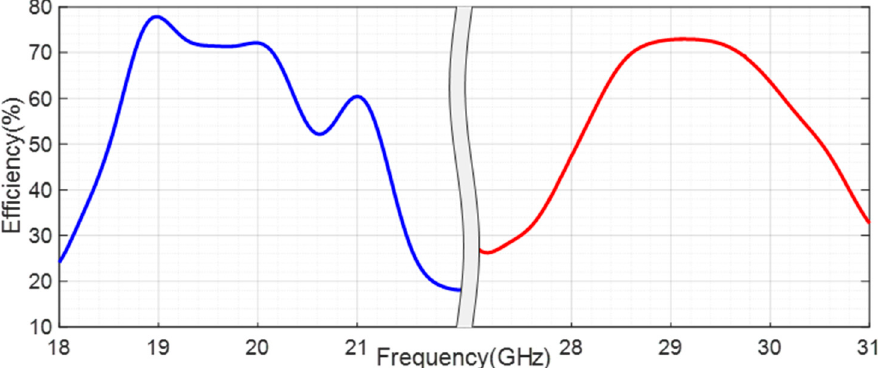
Figure 18. Simulated total efficiency of the filtenna.